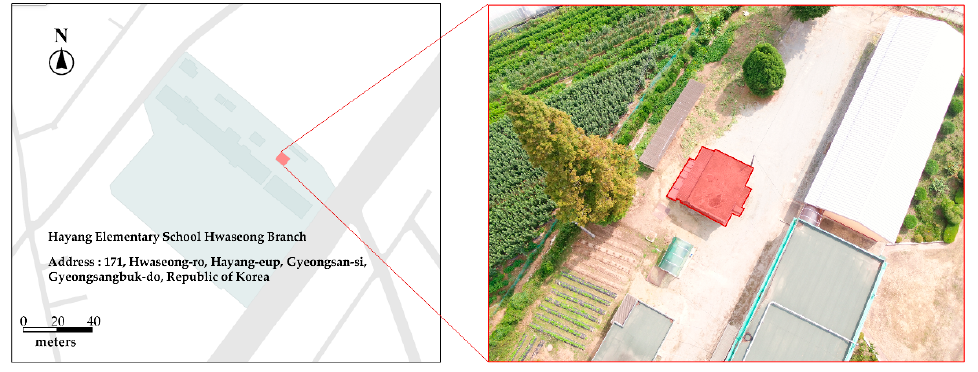
Figure 4. Overview of target site.